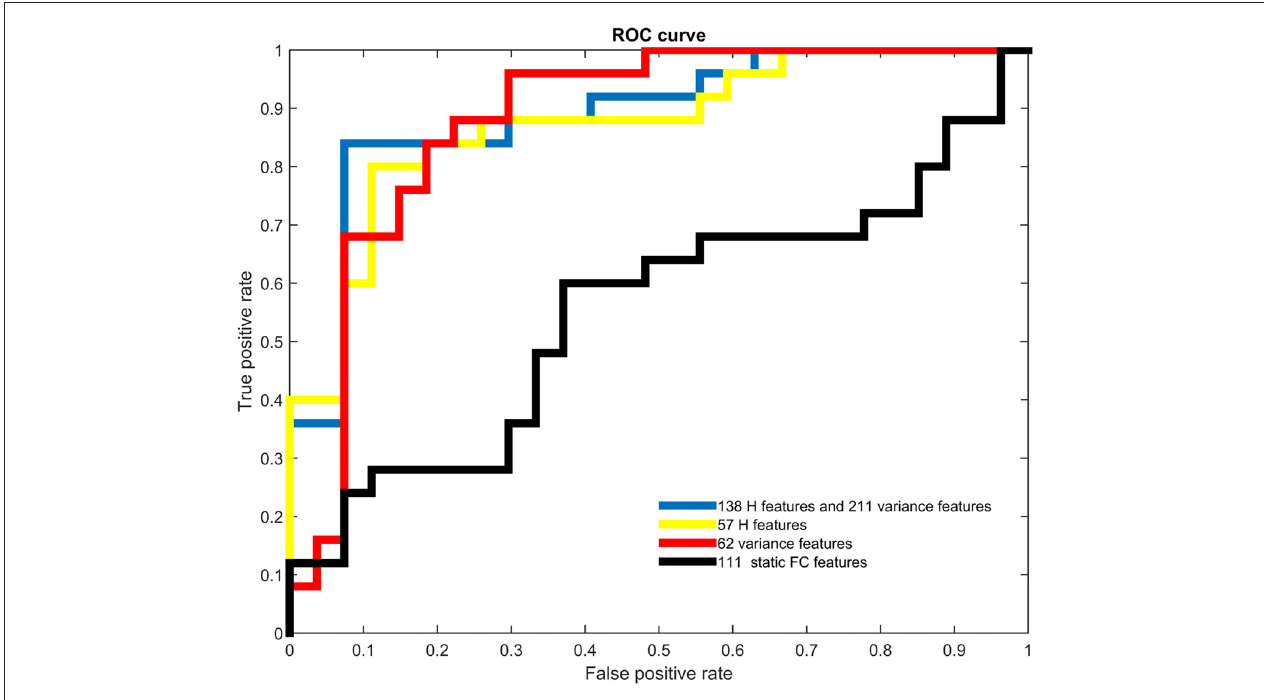
FIGURE 2 | Receiver operating characteristic (ROC) curves of different types of features. Different colors were used to represent the ROC curves of all four types of features.